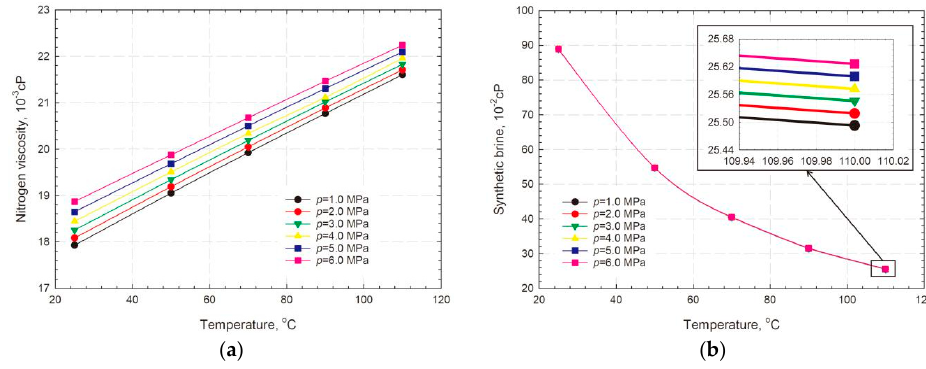
Figure 3. Sensitivity of ( a ) nitrogen and ( b ) synthetic brine viscosity to pressure and temperature.